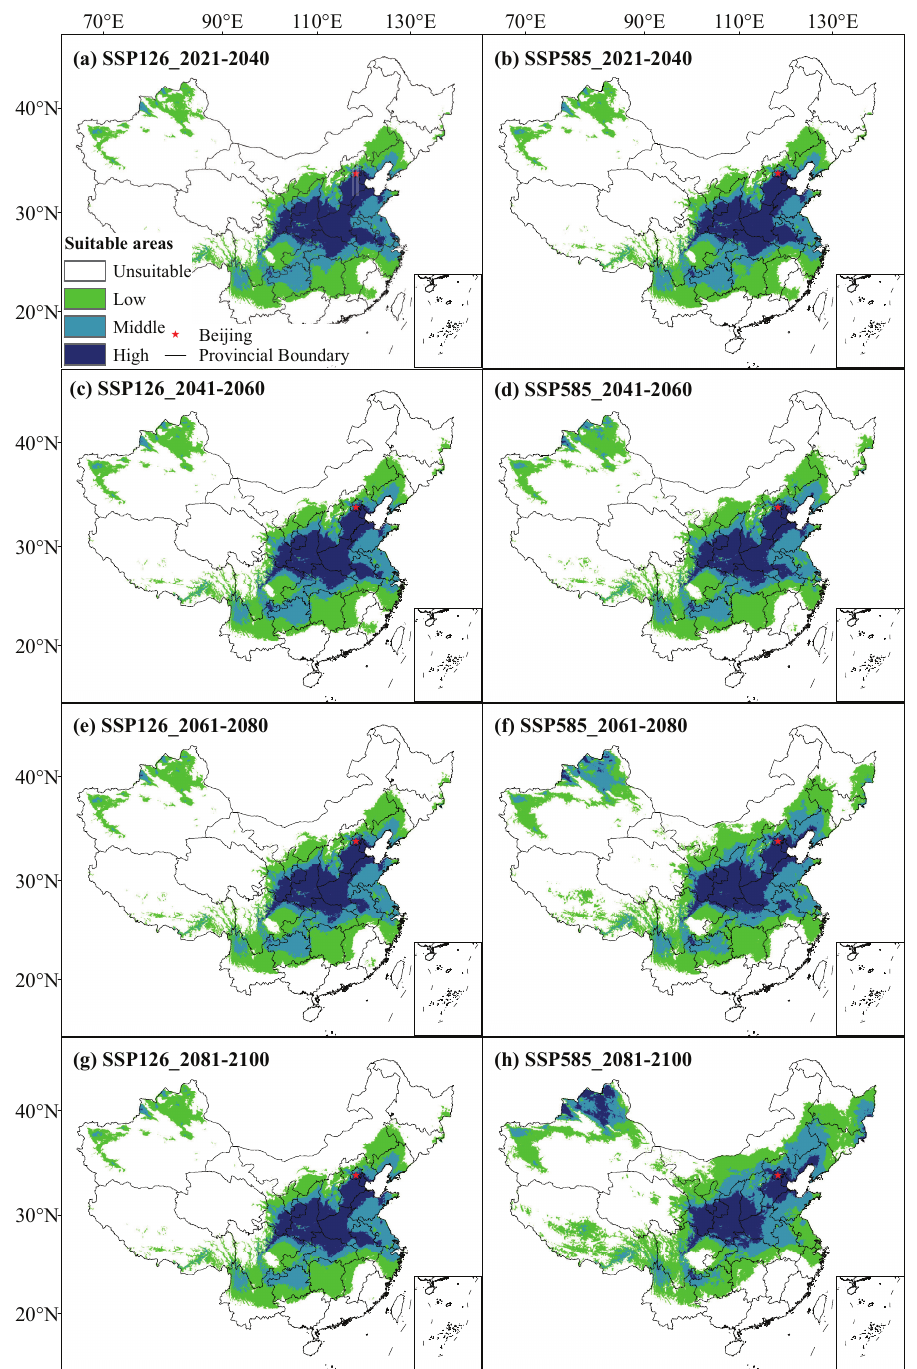
Figure 4. The potential distribution of C. bungei under future climate. Panels ( a , c , e , g ) indicate the potential distribution at four periods under SSP126, respectively; panels ( b , d , f , h ) indicate the potential distribution at four periods under SSP585,